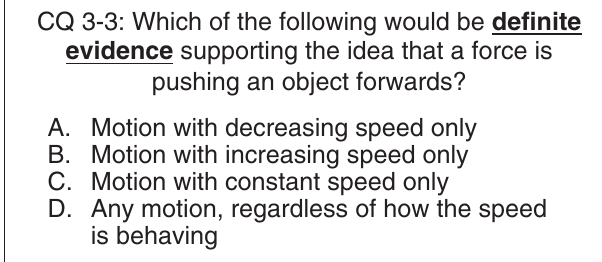
FIG. 13. Third clicker question in